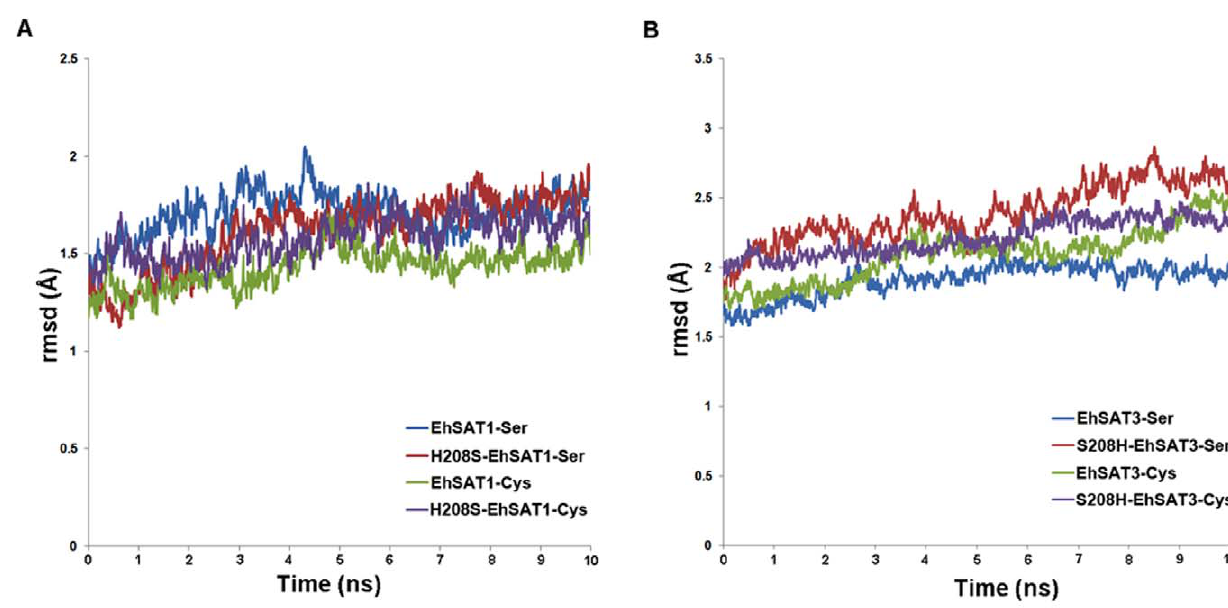
Figure 3. All atom root-mean-square deviations after performing 10 ns of molecular dynamics simulation of A) EhSAT1-cysteine & H208S-EhSAT1-cysteine, EhSAT1-serine & H208S-EhSAT1-serine B) EhSAT3-cysteine & S208H-EhSAT3-cysteine, EhSAT3-serine & S208H-EhSAT3-serine. The trend obtained from EhSAT1 & EhSAT3 showing slightly higher rmsd’s for the mutants compared to the native suggesting that the native forms are relatively more stable than the mutants.